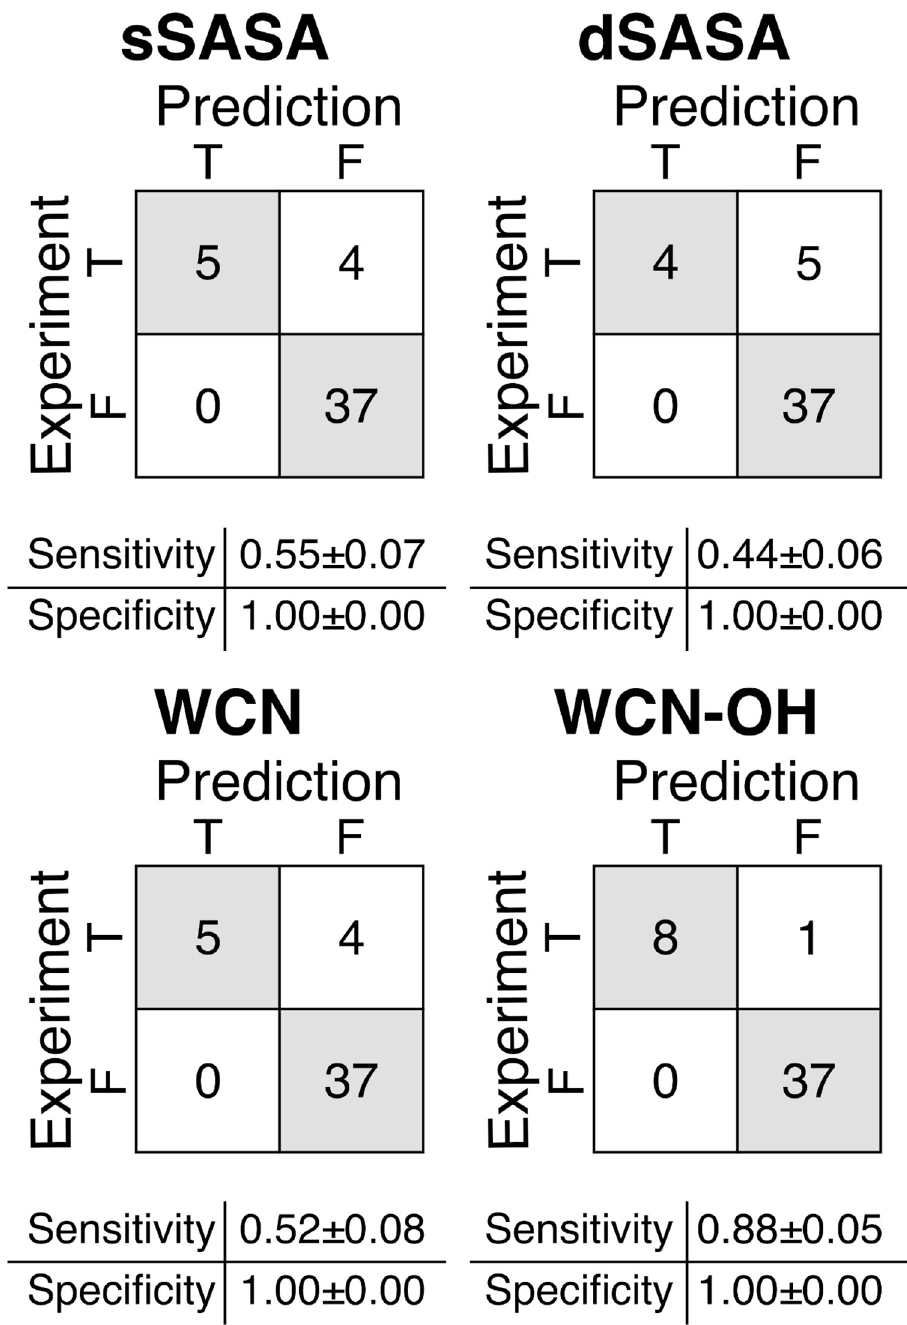
Fig 3. Confusion matrices for the in silico prediction of the oxidation events of the 14 CST antibodies. Confusion matrices reports TP, FN on the first row and FP, TN on the second row. Sensitivity calculated as TP/(TP+FN); Specificity calculated as TN/(TN+FP). TP = True Positive, TN = True Negative, FP = False Positive, FN = False Negative. Error for the sensitivity and specificity were estimated from 50 bootstrap